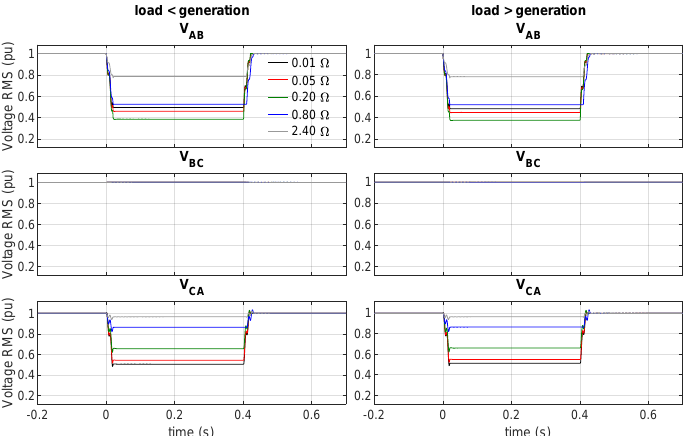
Figure 19. Phase–phase voltages at ST’s MV Inverter (AC side) following unbalanced phase–phase faults in the HV AC grid for the considered fault